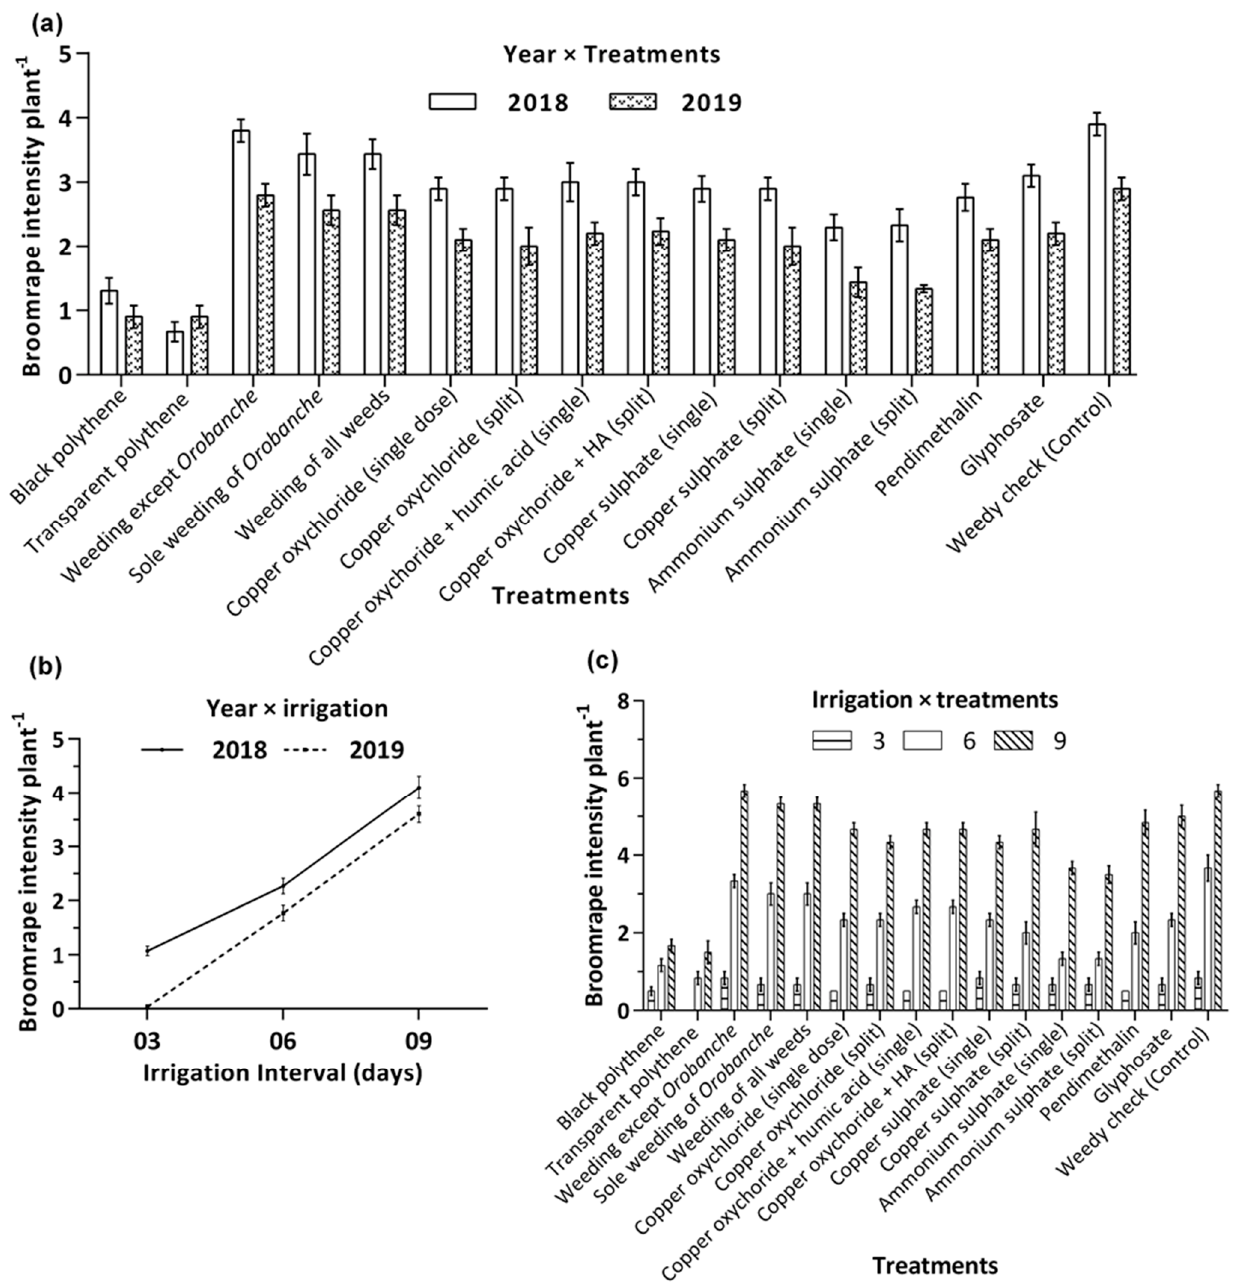
Figure 6. Influence of various interactions on broomrape intensity plant − 1 of tomato. ( a ) Interaction of year × treatments on broomrape intensity. ( b ) Interaction of year × irrigation on broomrape in ‐ tensity. ( c ) Interaction of irrigation × treatments on broomrape